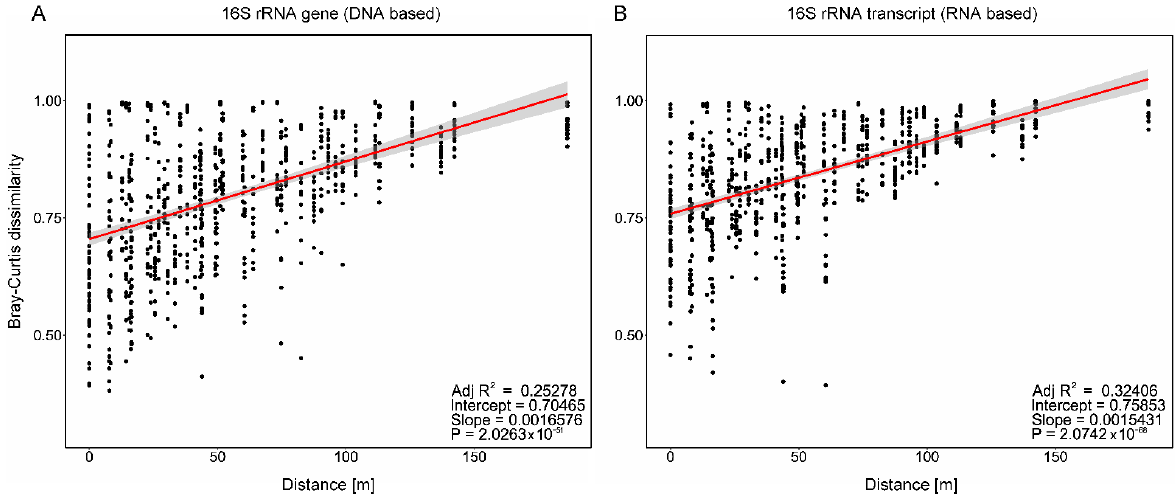
Figure 2. Distance – decay analysis. Pairwise Bray – Curtis dissimilarity over the geographic distance for ( A ) 16S rRNA genes (DNA-based) and ( B )-transcripts (RNA-based), independent of location and season. The red line represents a fitting linear model, with the 95% confidence level interval as the shaded area.